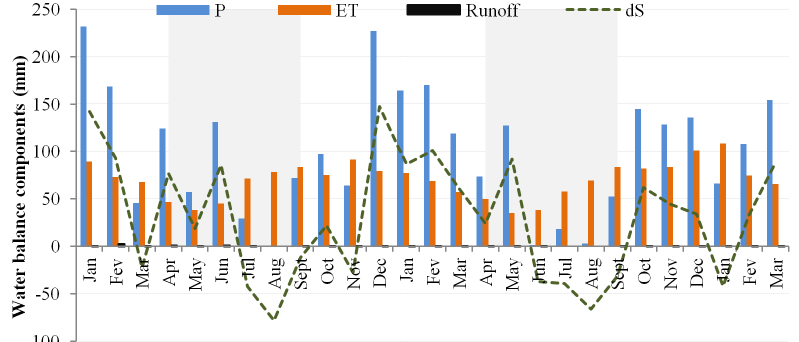
Figure 5. Water balance components at monthly scale from January 2012 to March 2014. The grey shaded bars show the dry seasons. P is precipitation, ET is evapotranspiration, and d S is soil water storage.